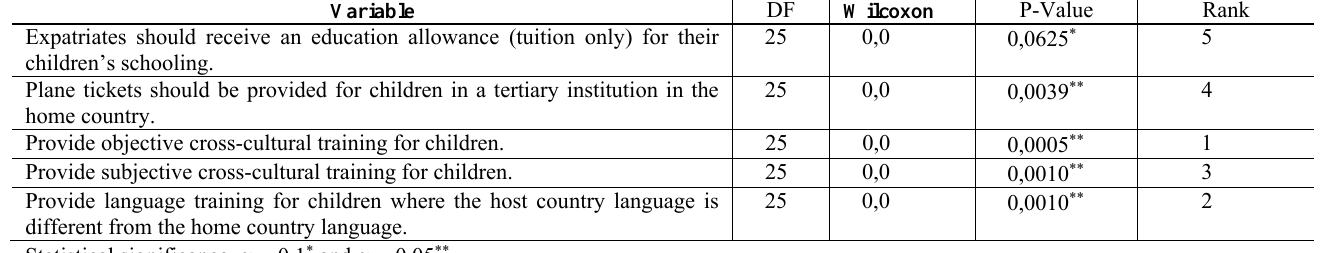
Table 6: Wilcoxon test for required vs. provided for expatriate children Variable DF Wilcoxon P-Value Rank Expatriates should receive an education allowance (tuition only) for their 0,0 0,0625 ∗ children’s schooling. Plane tickets should be provided for children in a tertiary institution in the 25 0,0 0,0039 ∗∗ home country. 25 0,0 0,0005 ∗∗